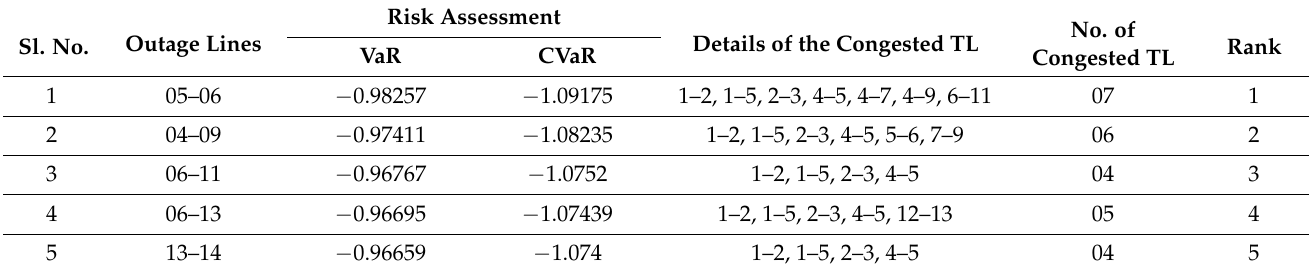
Table 1. Congestion and system risk in IEEE 14-bus